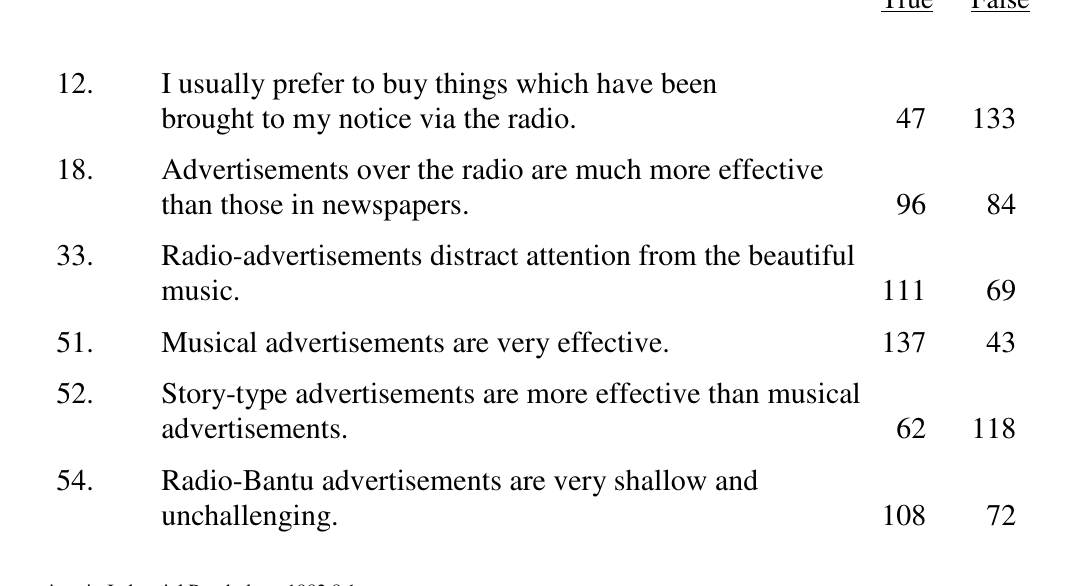
ITEMS REFLECTING AN ATTITUDE ON THE NATURE/MEDIUM OF